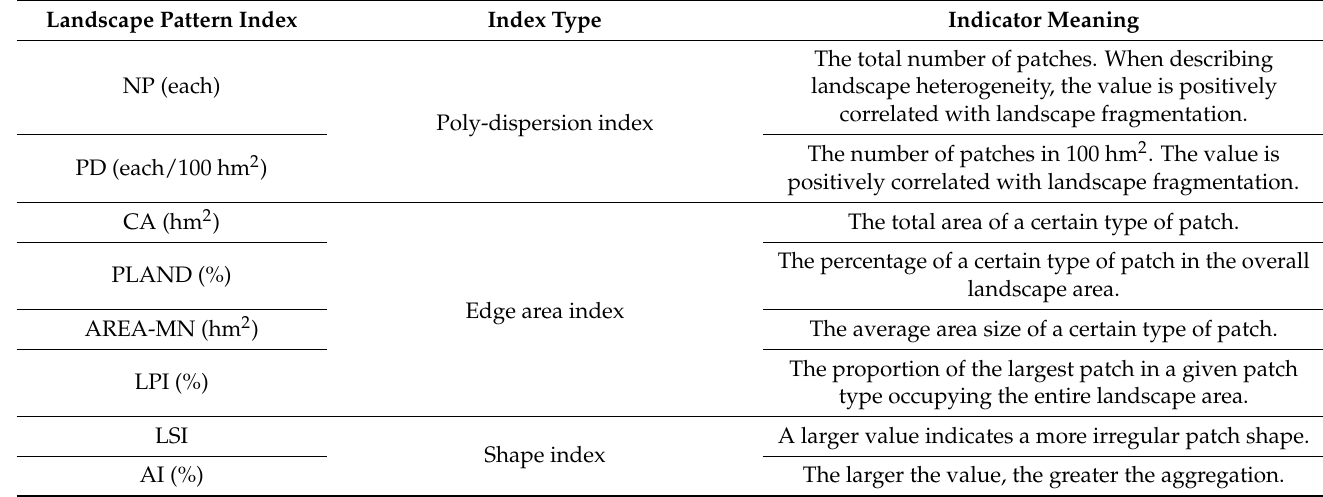
Table 1. The specific meanings of the indicators.